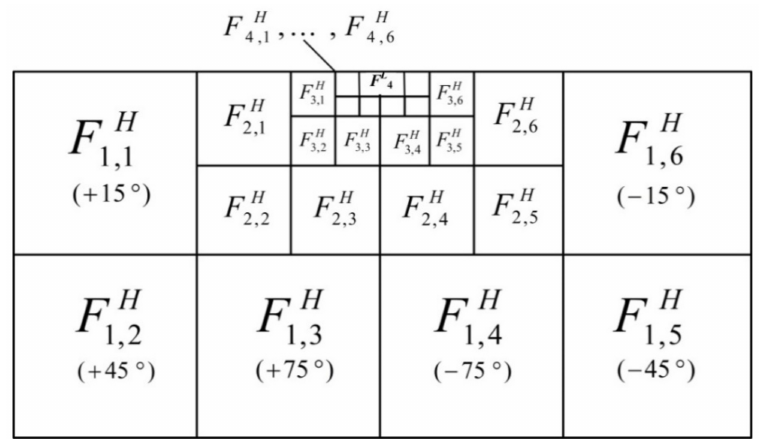
Figure 1. Four-level DT-CWT